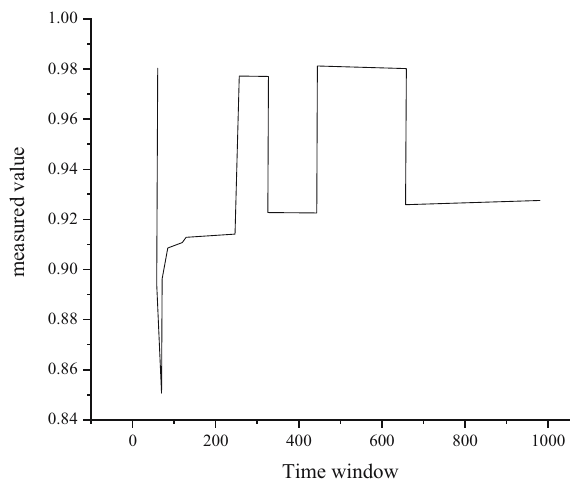
Figure 6: The defense situation of a simulated network security event